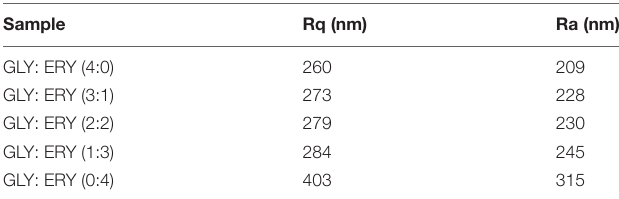
TABLE 3 | AFM of the corn starch-based films supplemented with GLY and ERY (4:0, 3:1, 2:2, 1:3,